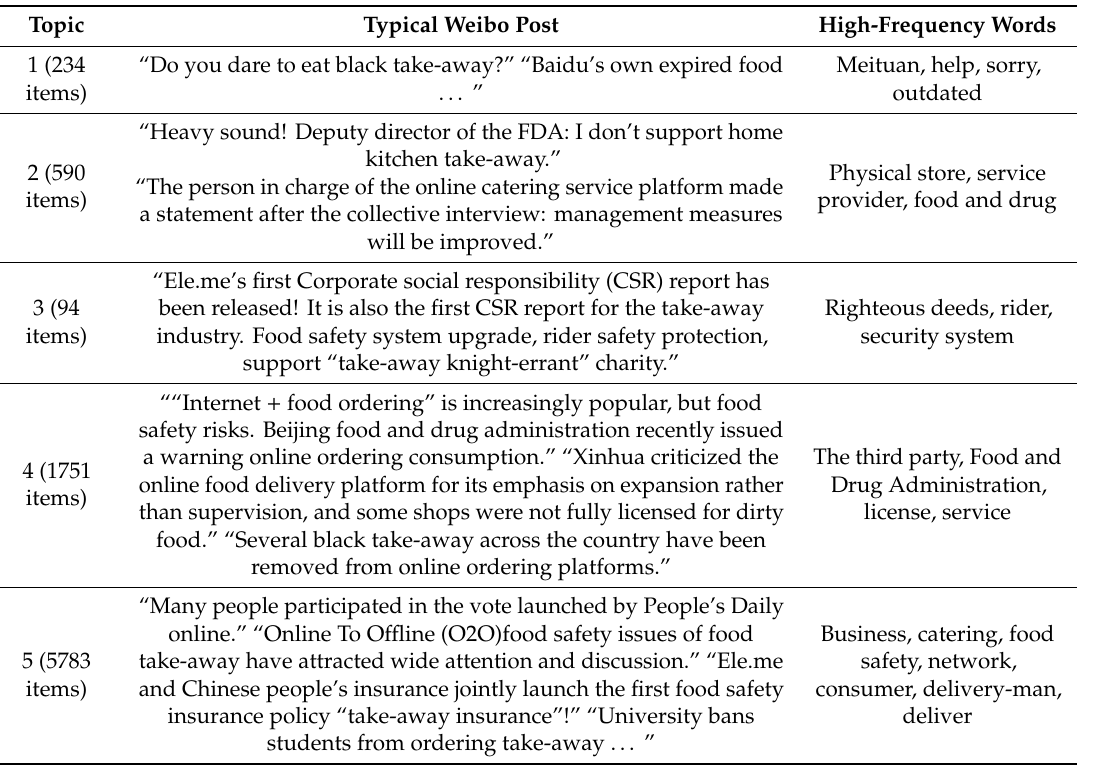
Table 7. Clustering